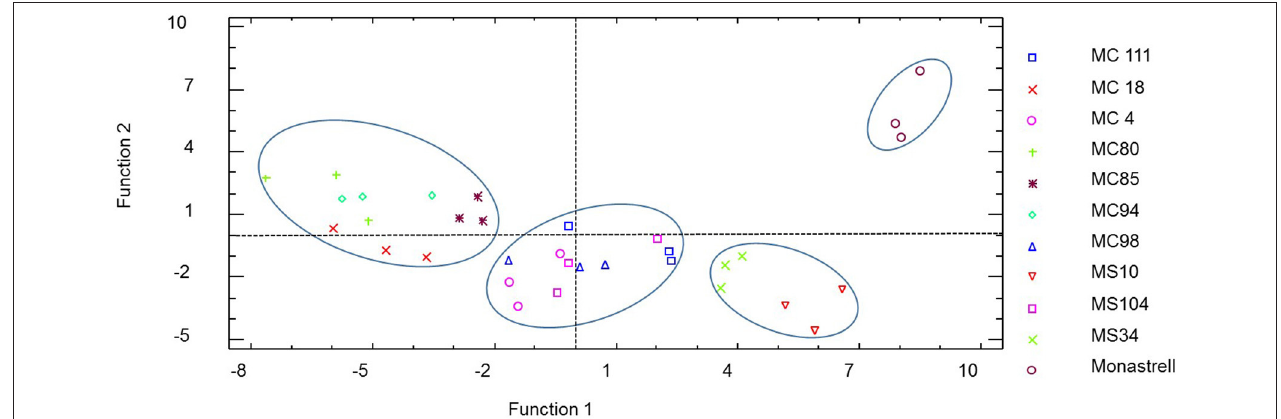
FIGURE 2 | Distribution of varieties in the two-dimensional coordinated system by two first discriminant